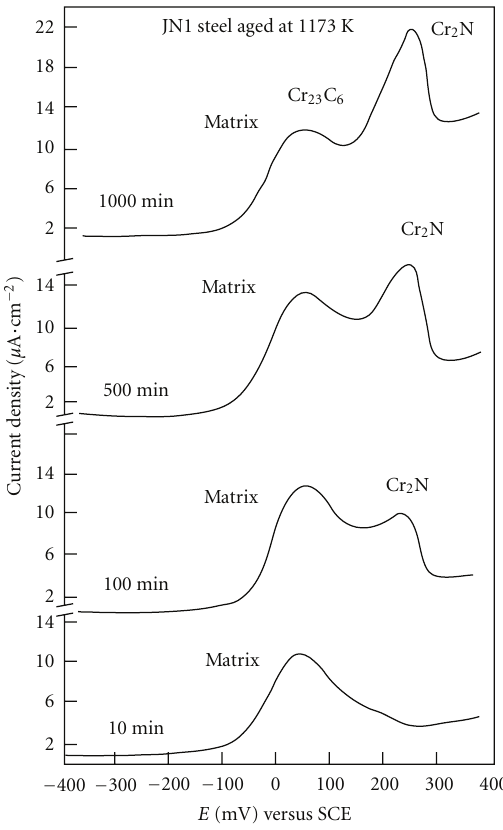
Figure 7: Anodic polarization curves of JN1 steel aged at 1173 K for 10, 100, 500, and 1000min.